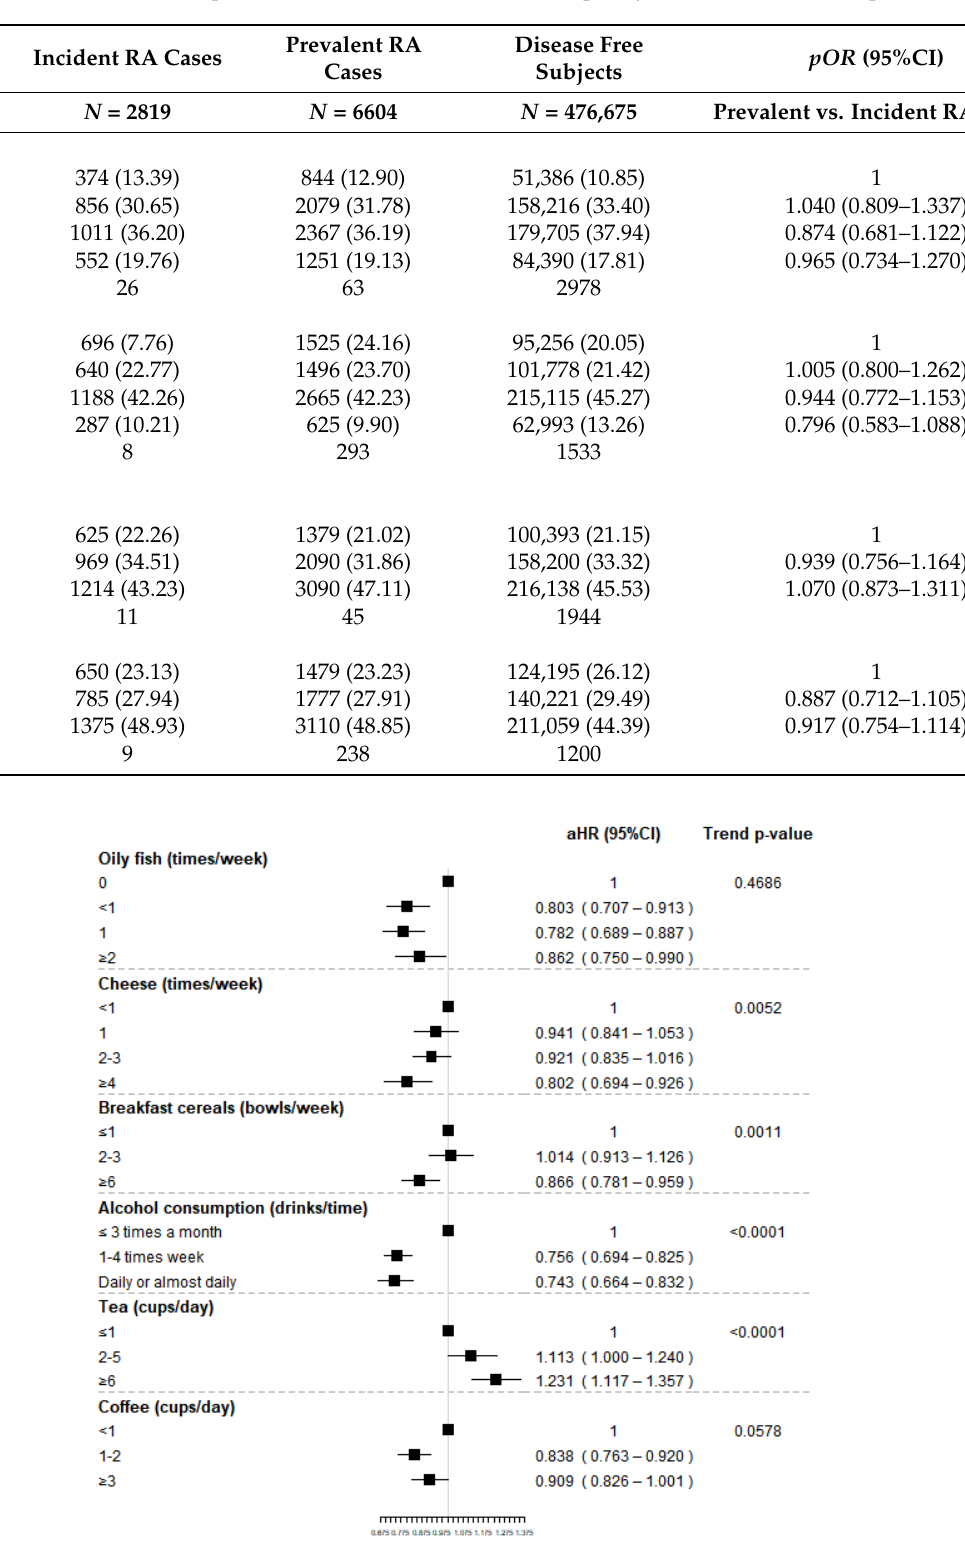
Table 3. Comparison of the distribution of food frequency levels of incident and prevalent RA cases.